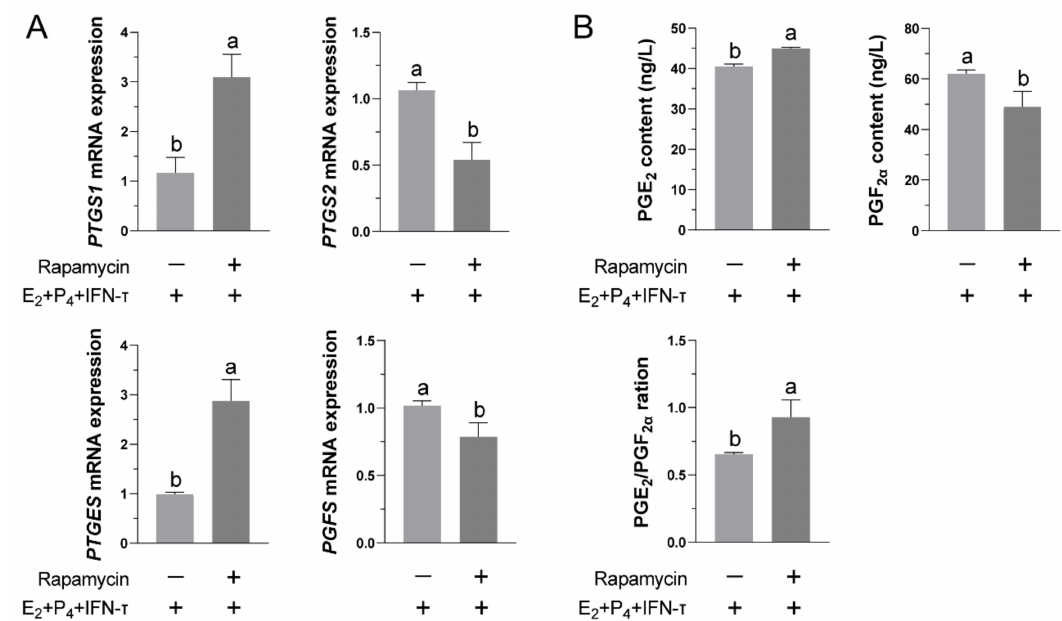
Figure 5. Effects of blocking the mTOR pathway on the secretion of PGs by STCs after hormone treatment: ( A ) Relative mRNA levels of prostaglandin synthases in rapamycin (Rap)-pretreated STCs were determined by real-time fluorescence quantification. The β -actin gene was used as the control in all samples. ( B ) After blocking the mTOR pathway, the secretion of PGE 2 and PGF 2 α was measured by ELISA, and the ratio of PGE 2 /PGF 2 α was calculated. Data are shown as the mean ± standard deviation (SD) of three independent trials. Different letters above the bars indicate significant differences ( p <